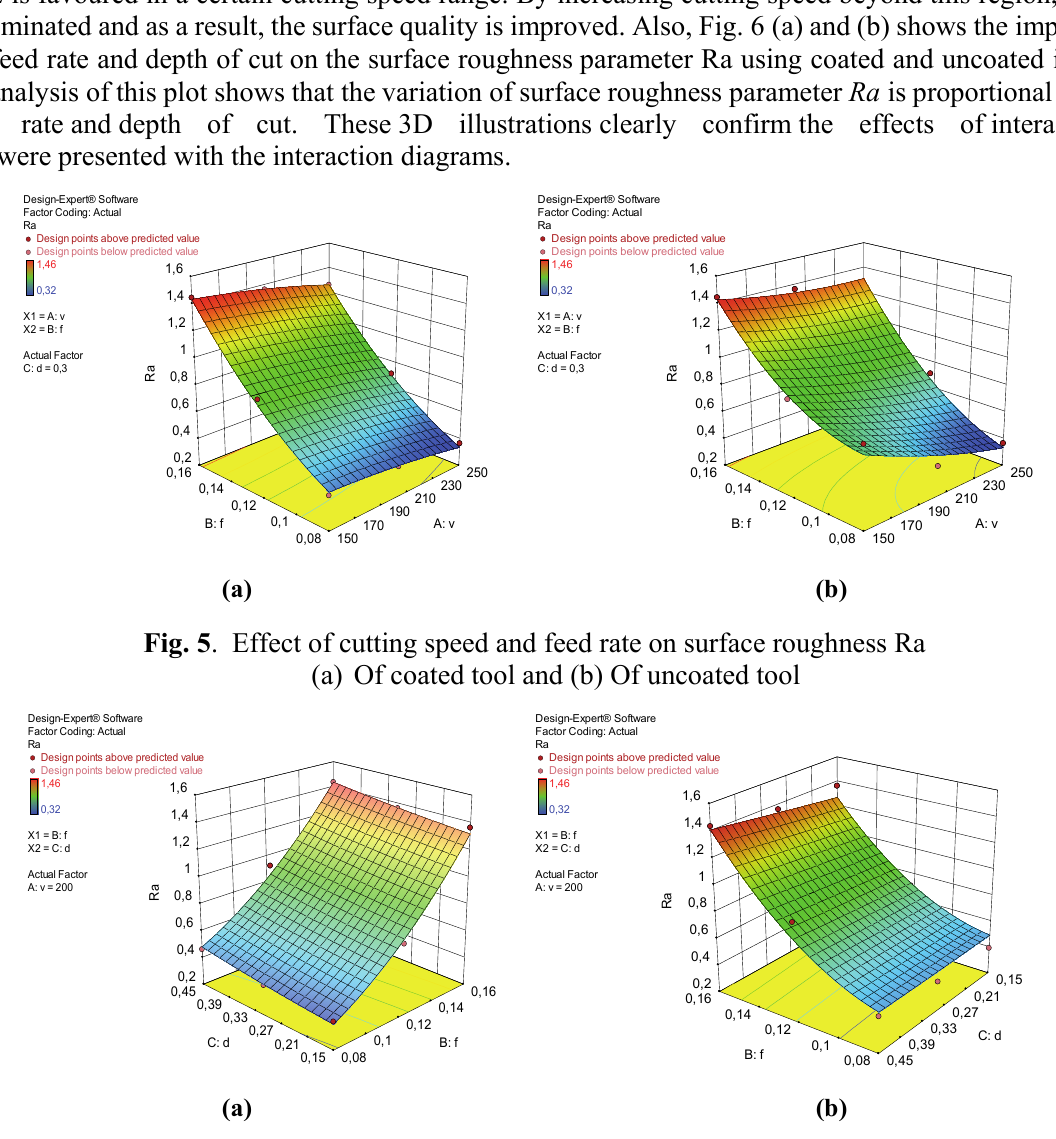
Fig. 6. Effect of feed rate and depth of cut on surface roughness